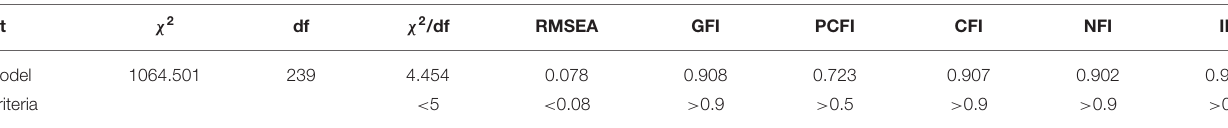
TABLE 2 | Model fit